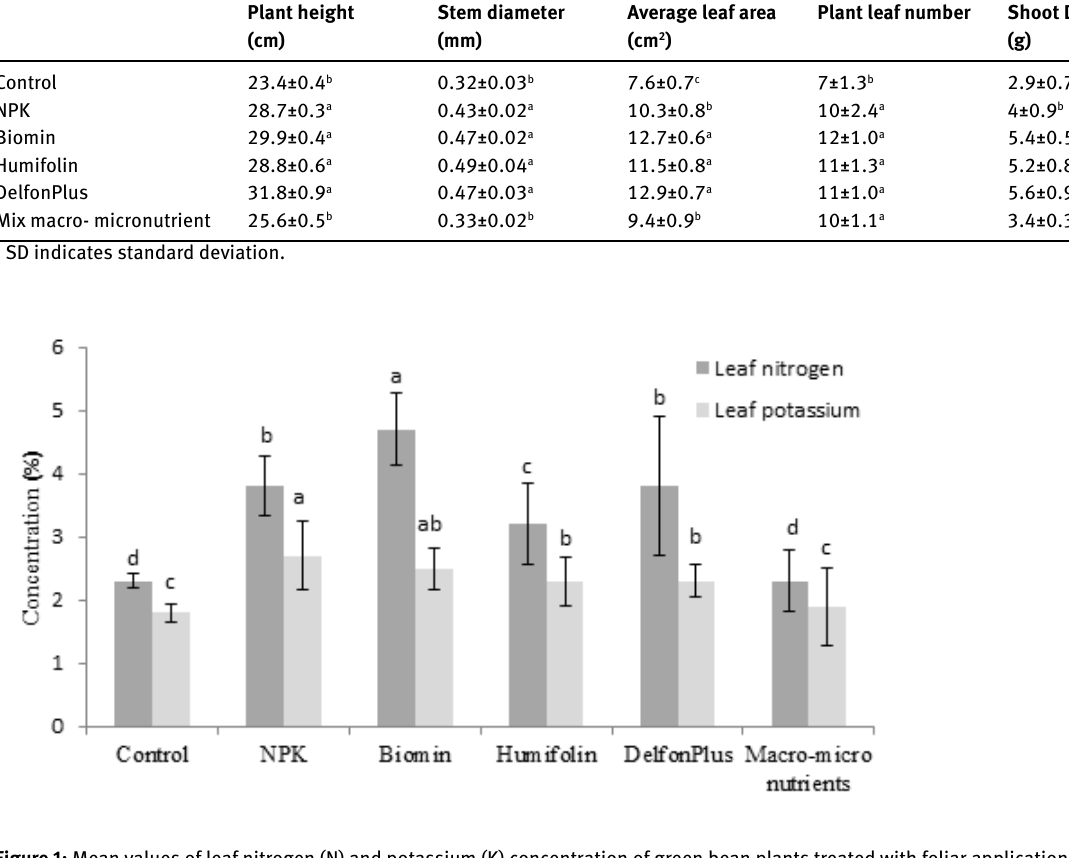
Figure 1: Mean values of leaf nitrogen (N) and potassium (K) concentration of green bean plants treated with foliar applications of different organic chelates, a mix of nutrients and soil applied NPK under greenhouse conditions. Bars indicate standard deviation. Different letters within each element (N or K) across all foliar treatments are statistically different